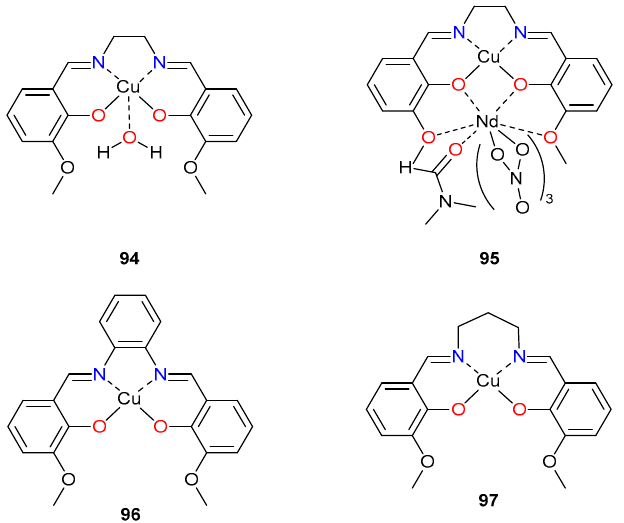
Figure 16. Cu II -[ONNO] complexes active in the ROP of lactide [63–66].